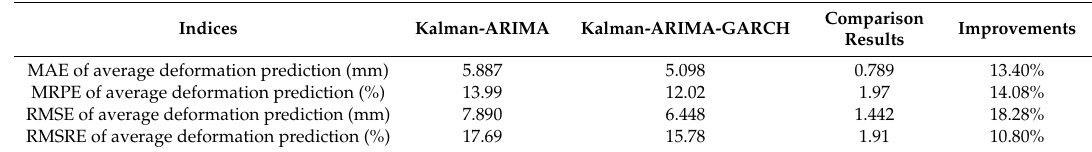
Table 3. Analysis of the predictions given in Figure 12.